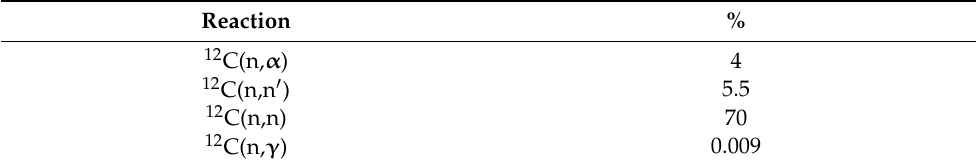
Table 5. Calculated reaction rates for some reactions occurring in carbon (neutron energy > 5